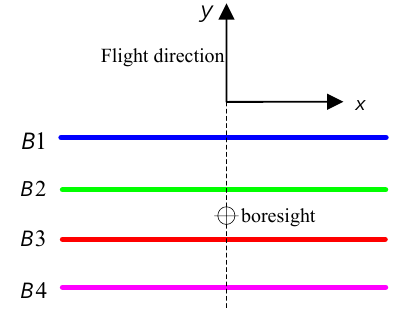
Figure 1. Design of multi-spectral camera onboard HROS